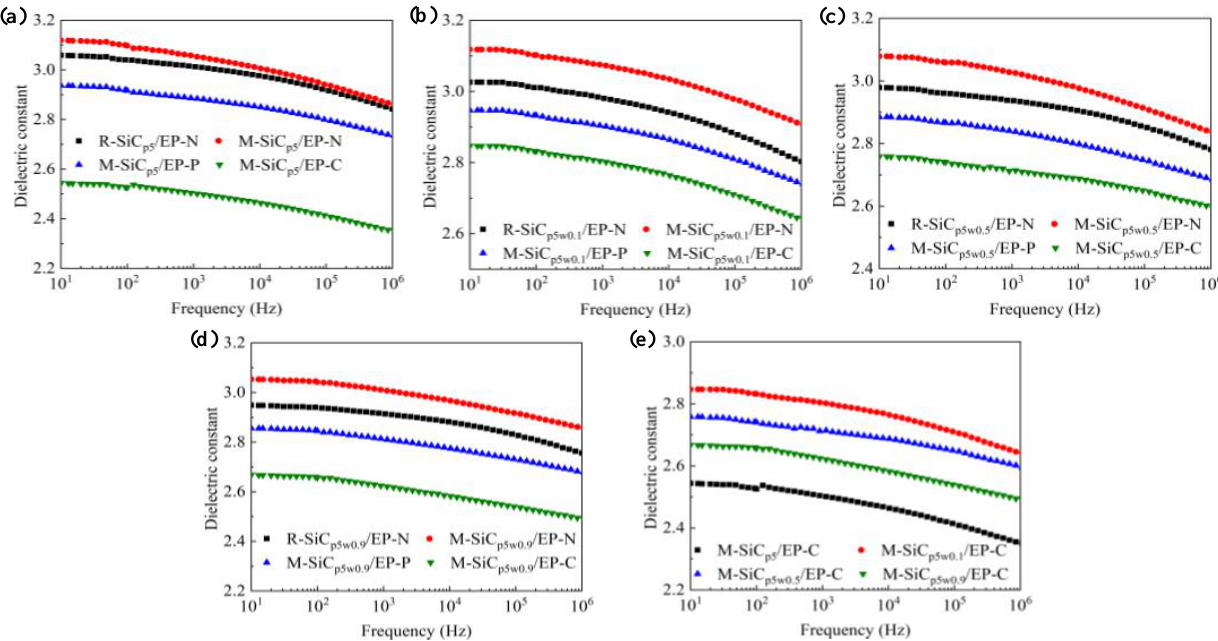
Figure 9. Dielectric constant spectra. ( a ) SiC p5 /EP; ( b ) SiC p5w0.1 /EP; ( c ) SiC/EP p5w0.5 ; ( d ) SiC p5w0.9 /EP; ( e ) M-SiC/EP-C.